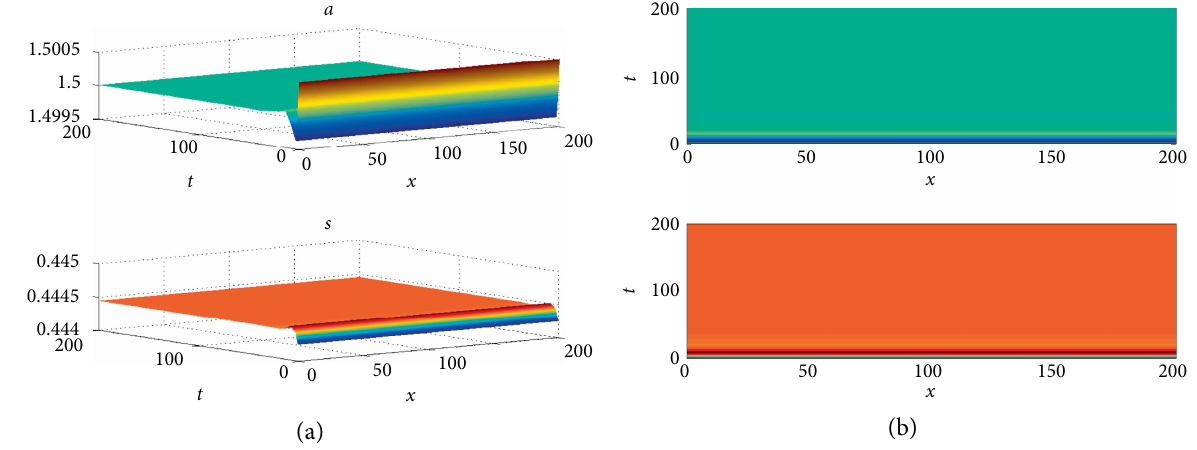
and and (b) the 𝑑 = 0.38